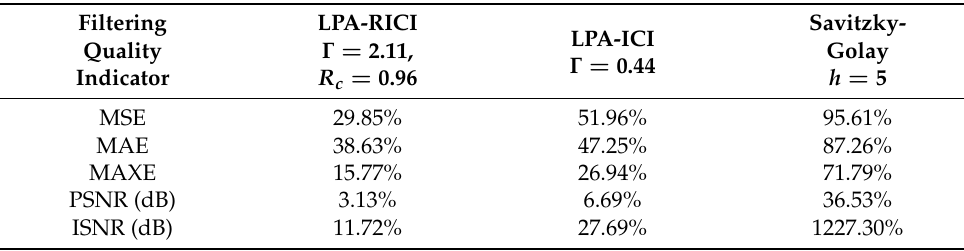
Table 41. Sing signal (SNR = 10 dB)—Filtering quality improvement of the RBF-RICI-based filtering over other tested algorithms.